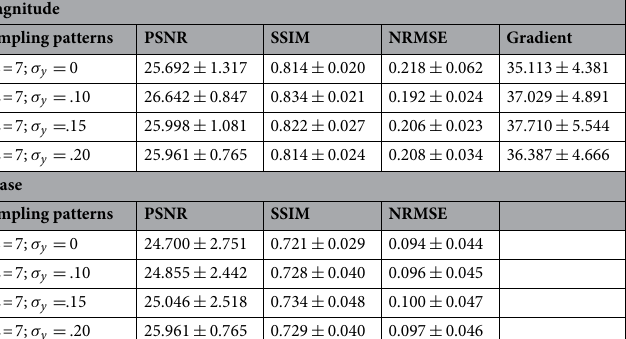
Table 2. Summary of performance obtained on magnitude and phase images for different sampling patterns. Acceleration rate = 5.